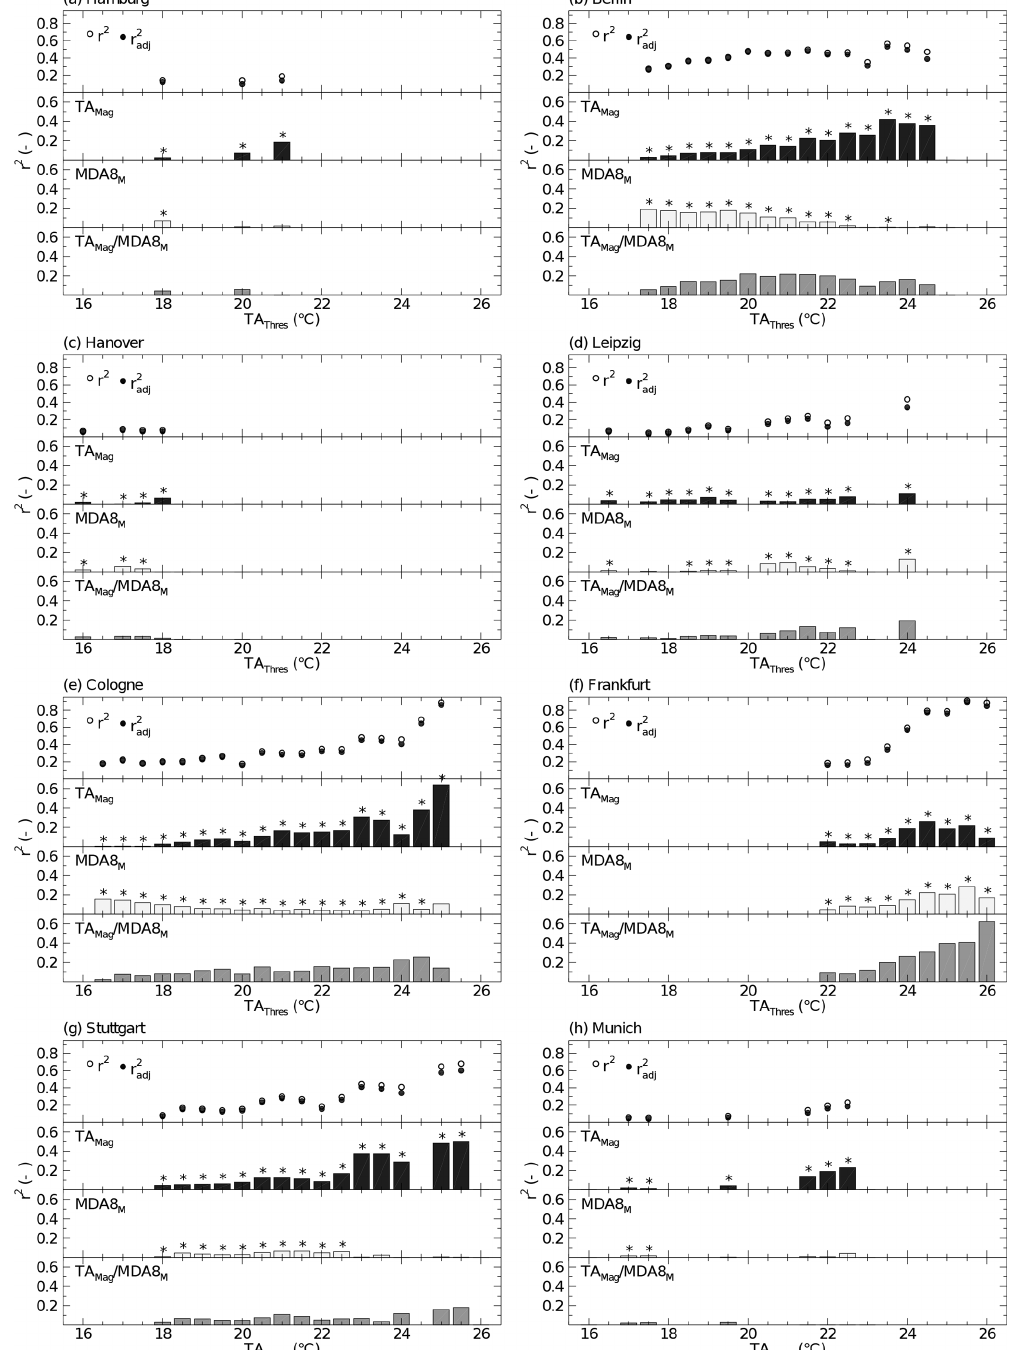
Figure 3. Results of the multiple linear regression (MLR) analysis between the predictor variables TA Mag and MDA8 M and the mean mortality rate during HWEs as an independent variable. Each panel shows results for one city and different TA Thres ( x axis). Top row of each panel shows overall r 2 (empty circles) and r 2 (filled circles) of MLR models. Partitioned r 2 ( y axis) is shown in the lower three rows adj for the predictors TA Mag (top, black), MDA8 M (middle, light gray) as well as the interaction term of TA Mag and MDA8 M (bottom, dark gray). Only results of overall statistically significant ( F test, p < 0.05) MLR models are displayed. Statistical significance of each predictor variable ( p < 0.05) is marked with a star above each